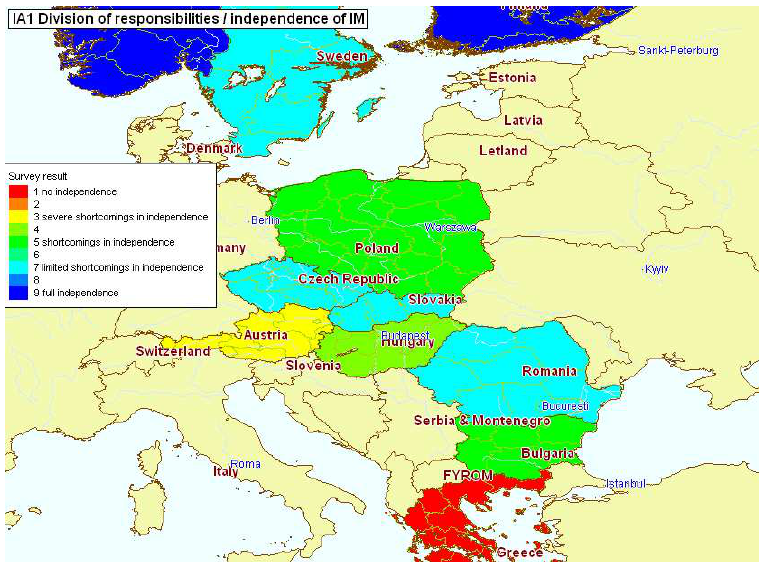
Figure 1. Thematic map for requirement IA1 (Independence of Infrastructure